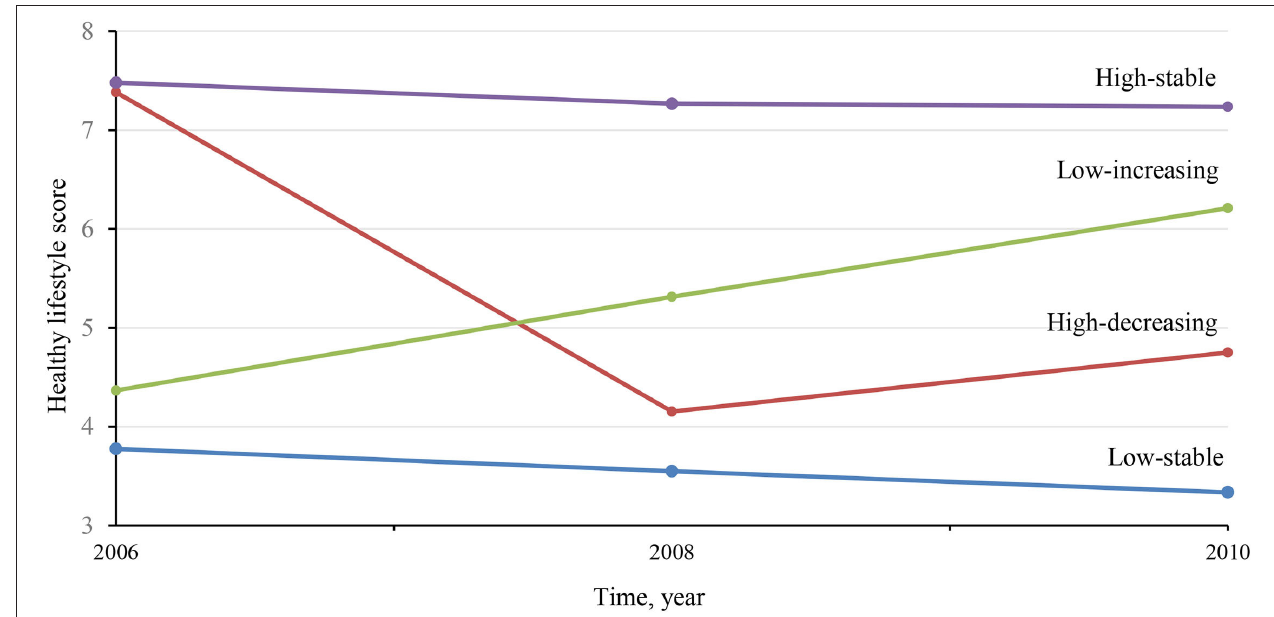
FIGURE 1 | Mean healthy lifestyle score in 2006, 2008 and 2010, according to four healthy lifestyle score trajectories.